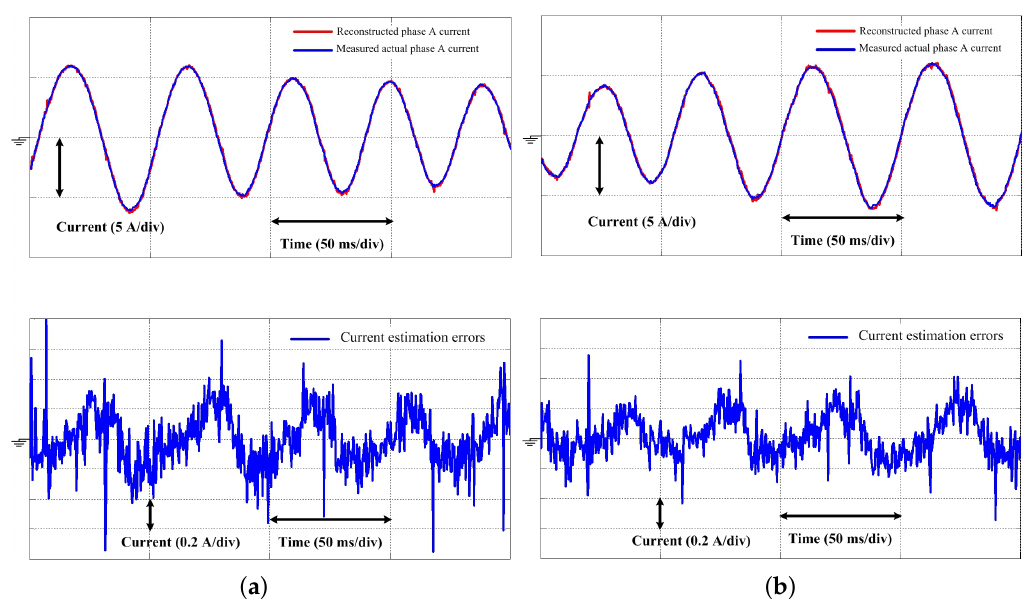
Figure 20. Reconstructed and actual measured phase A currents as well as the current estimation errors of phase A at variable load; time scale: 50 ms/div. ( a ) from 5 N · m to 3 N · m; and ( b ) from 3 N · m to 5 N ·